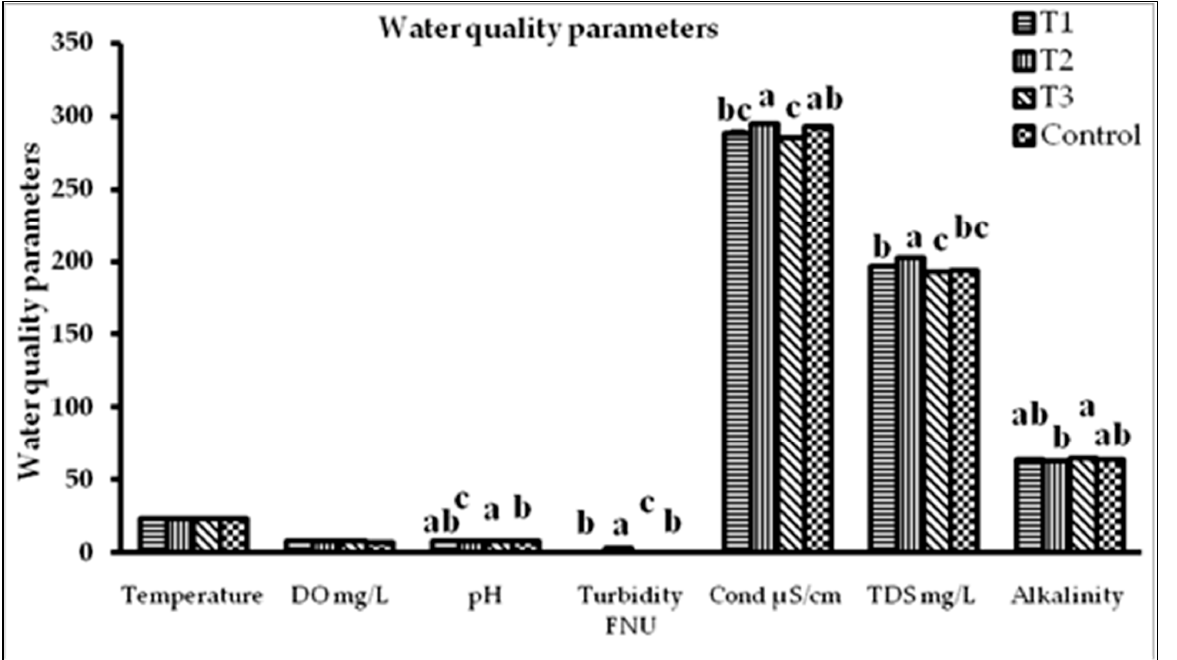
Figure 5. Water quality parameters in different treatment groups of rosy barb during the experimental period. Each value is expressed as mean ± standard error (M ± SE). Different letters (a,b,c) indicate significant differences determined via Duncan’s test ( p< 0.05), n = 3.